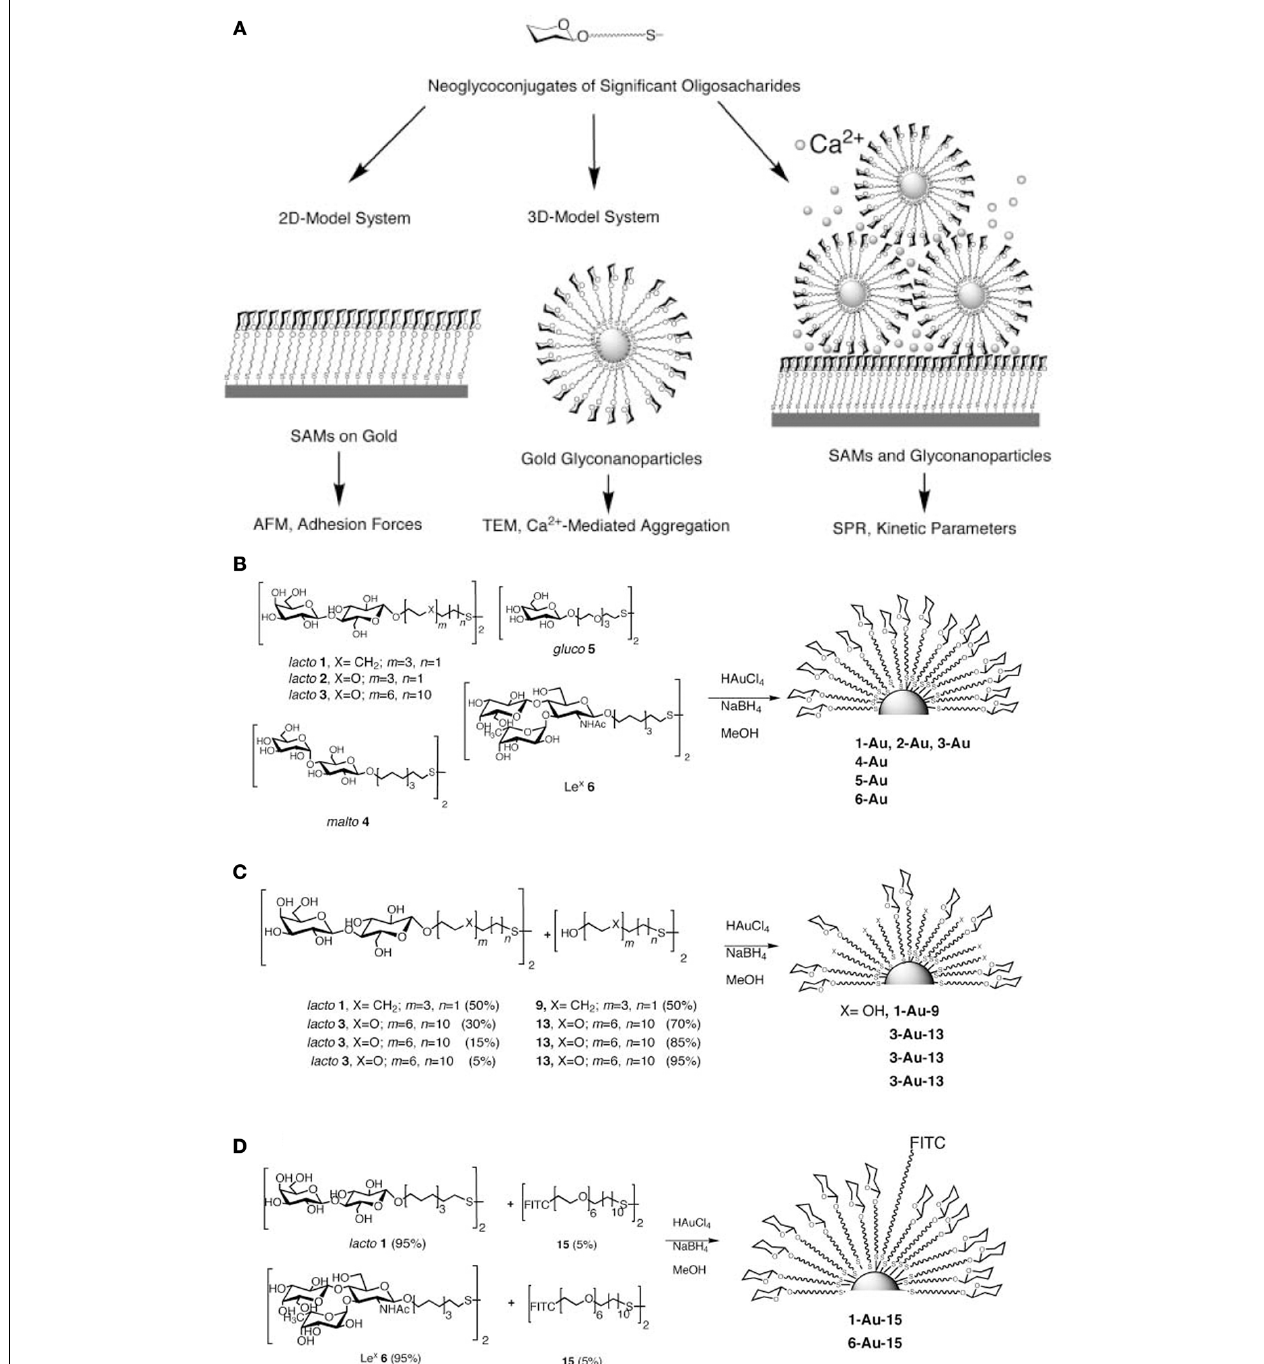
FIGURE 7 | Gold glyconanoparticles. (A) Strategy for studying carbohydrate ± carbohydrate interactions based on 2D and 3D models that mimic carbohydrate presentation at the cell surface. Preparation of